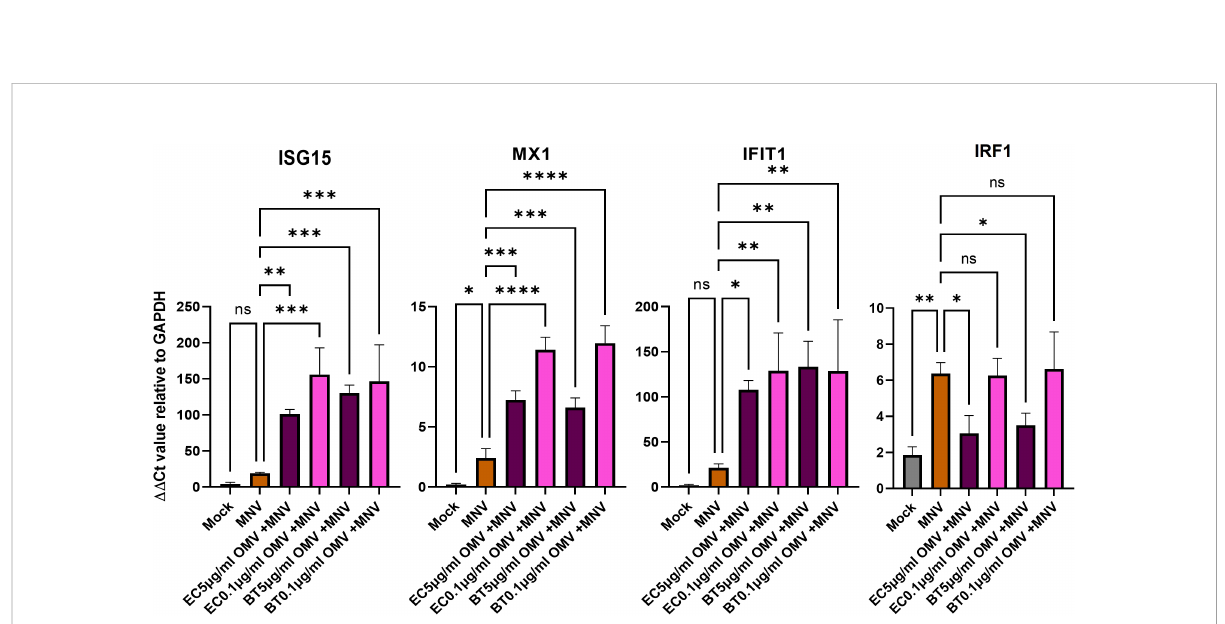
FIGURE 6 ISG gene expression analysis. RAW264.7 cells were infected with mock virus, MNV, OMVs, and OMVs+ MNV. ISG15, MX1, IFIT1, and IRF1 expression were measured in the cells at 18 hpi. All the treatments were compared to ISGs expression in MNV only infected RAW264.7. Ordinary one-way ANOVA was used to analyze qRT-PCR results. (n=3; ns= not signi fi cant, *=p<0.05, **=p<0.01, ***=p<0.001, ****=p<0.0001). Results showed that the presence of OMVs frequently induced signi fi cant changes in ISG expression. Ns= not signi fi